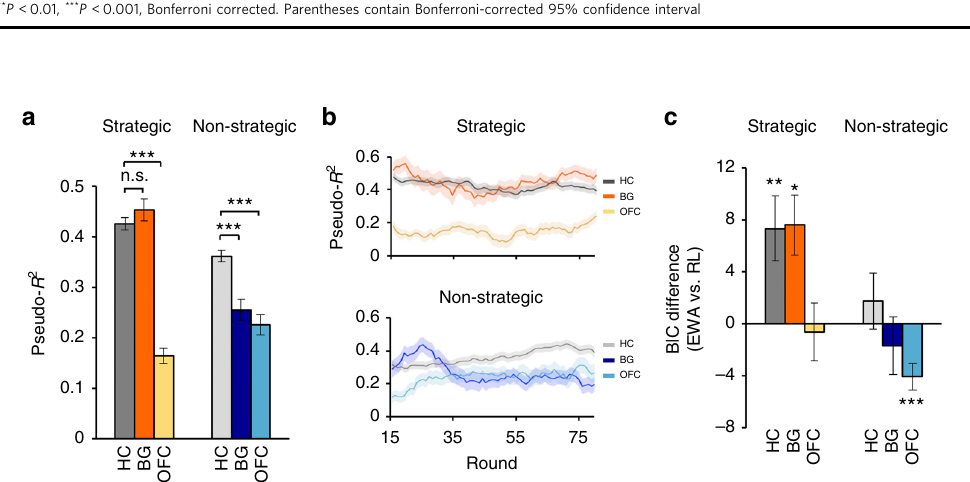
Fig. 3 Computational modeling. a Differential ability of EWA in explaining choice behavior. The bar plots depict values of pseudo- R 2 derived from the best- fi tting EWA, de fi ned as the difference between the log-likelihood of the EWA model and a random choice model, scaled by log-likelihood of the random model. Higher pseudo- R 2 values indicate better model fi t relative to chance level. The means and error bars were constructed using a bootstrap procedure with 10,000 iterations pooling over cohorts for each condition. b Trial-level EWA model fi t based on pseudo- R 2 plotted using 15-trial bins. c Bayesian Information Criterion (BIC) showing signi fi cant improvement of the hybrid model fi t relative to the baseline RL model, in HC and BG cohorts under the strategic treatments, calculated using a bootstrap sampling procedure with 10,000 iterations. Error bars indicated bootstrap S.D. and shaded areas indicate